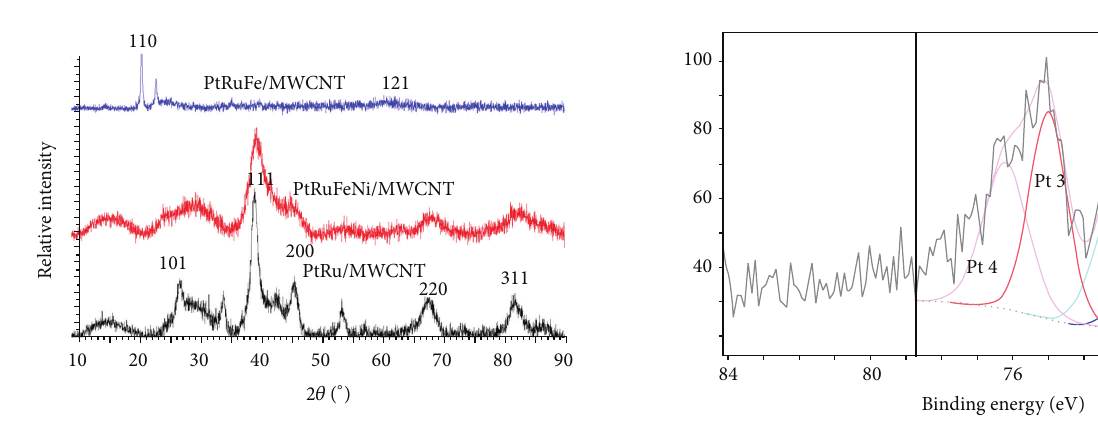
Figure 4: XRD patterns of PtRu/MWCNT, PtRuFeNi/MWCNT, and PtRuFe/MWCNT.